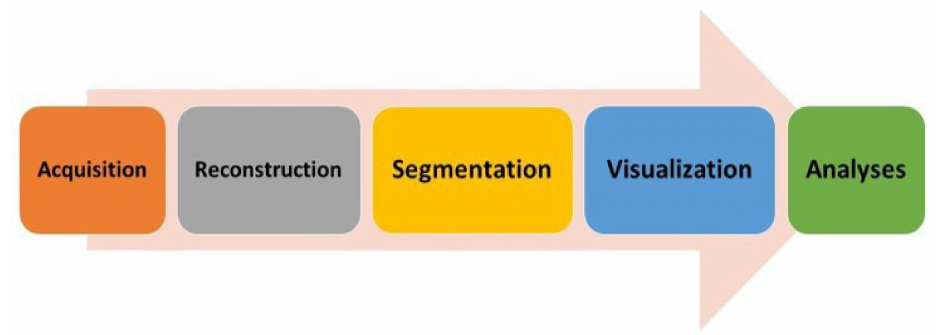
Figure 1. Process engineering ERT workflow (left to right): data acquisition, image reconstruction, image segmentation, 2D/3D visualization, and process analyses for control and